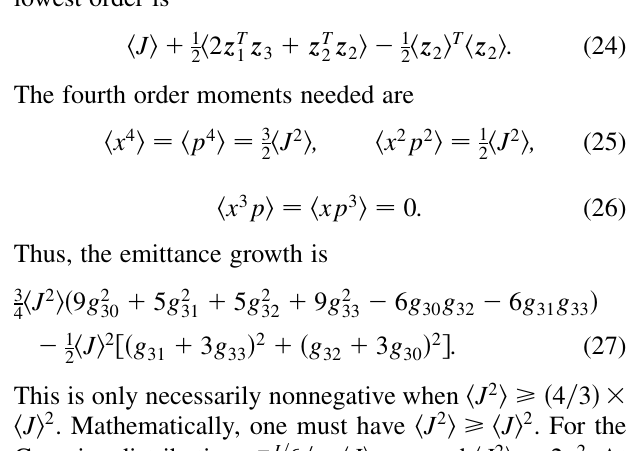
FIG. 5. Value for b which gives the minimum emittance growth.